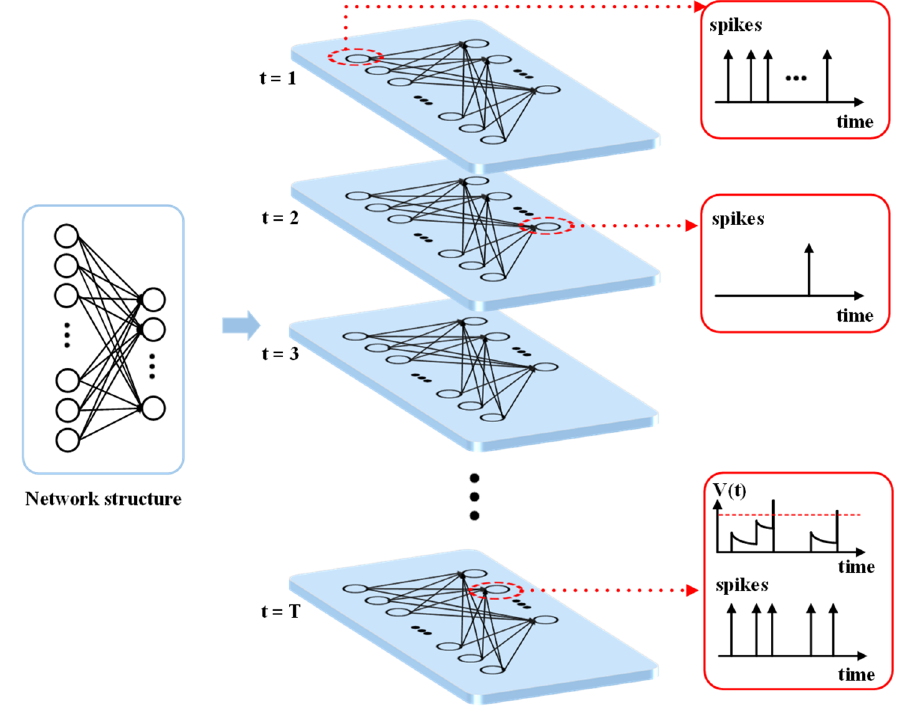
Figure 3. Illustration of the firing and propagation of spikes in the SNN. Each neuron in the network receives both spatial spikes from various neurons and temporal spikes at different times. These spikes will cause the change of membrane voltage of neurons, and if it exceeds V threshold , its value will be reset to V reset after the neuron fires a spike to the connected